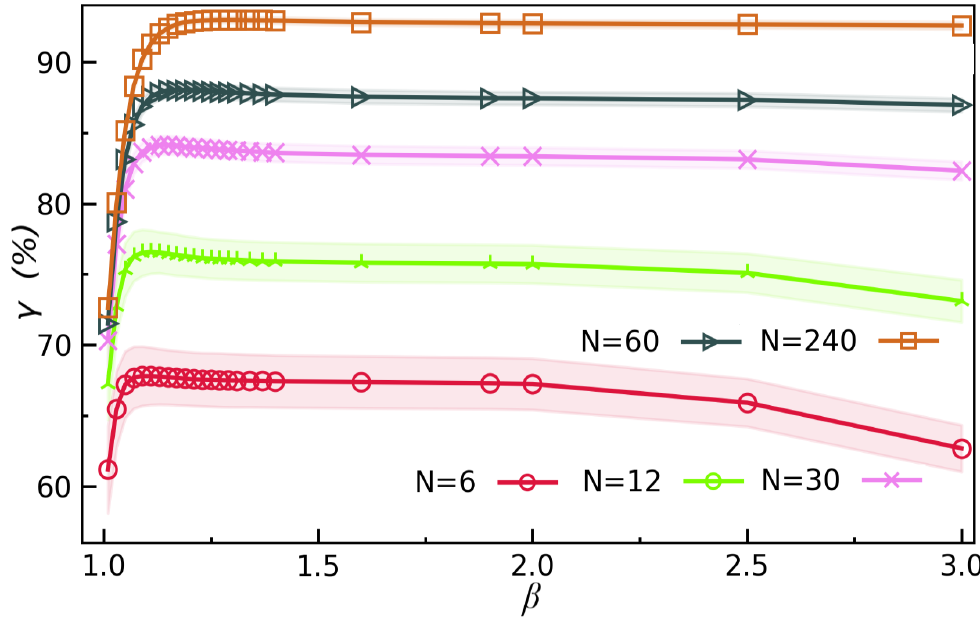
Figure 2. Testing accuracy γ of non-parametric supervised learning using rescaled logarithmic fidelity (RLF-NSL) on the MNIST dataset with different number of labeled samples N in each